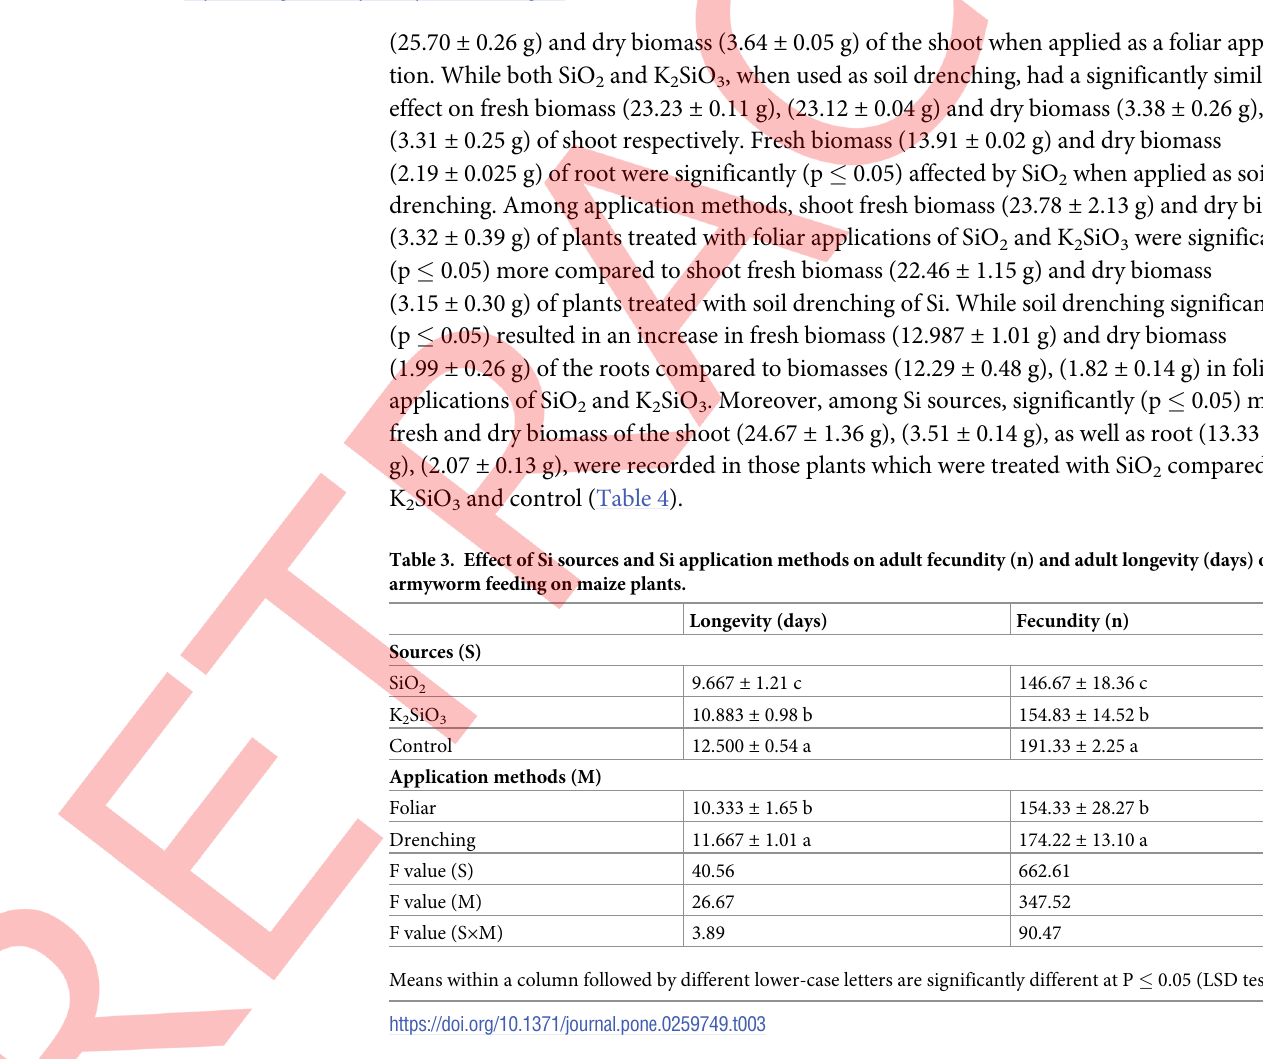
Fig 3. Effect of Si sources and application methods on (a) adult fecundity (n) and (b) adult longevity (days) of fall armyworm. Bars with different lower-case letters are significantly different; LSD test at p � 0.05. Vertical bars indicate SD.